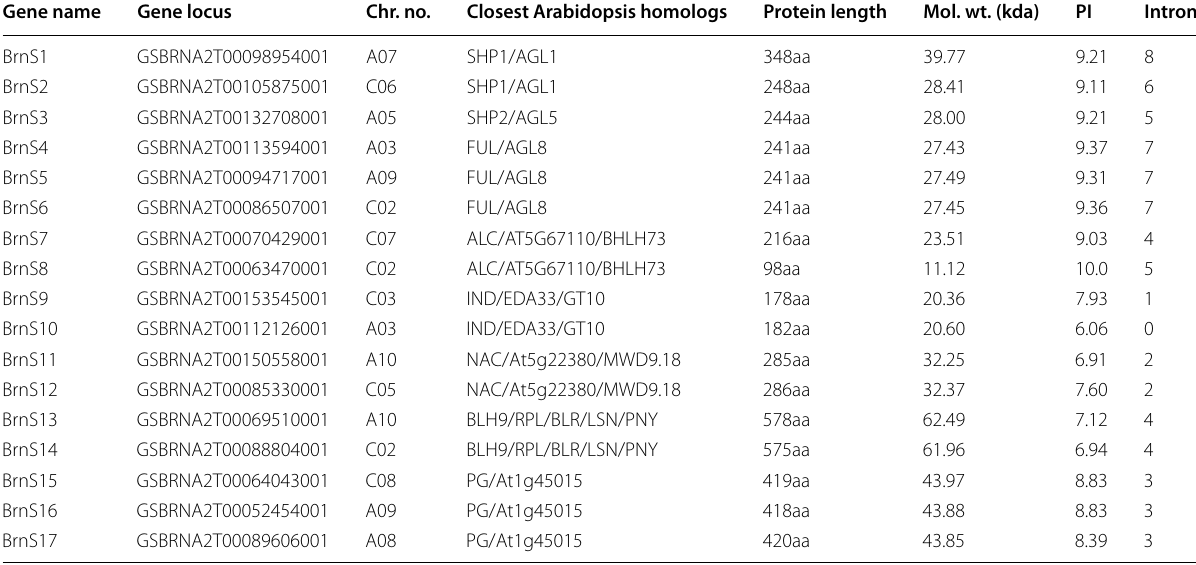
Table 2 In silico study of 17 shattering genes identified in B. napus with their closest Arabidopsis homologs and sequence feature